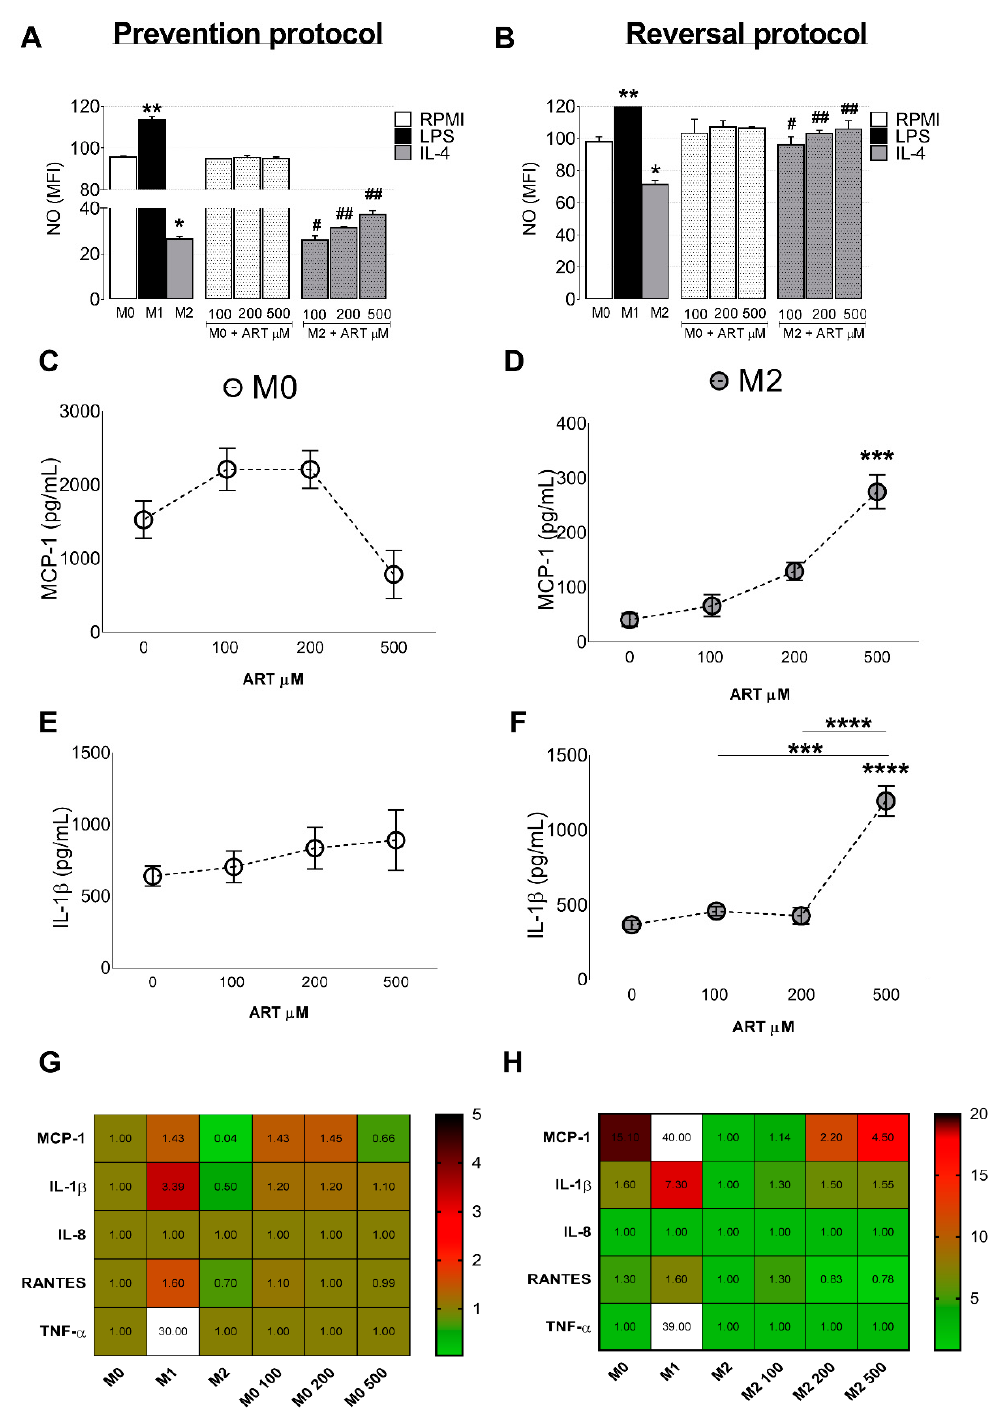
Figure 4. ART treatment induces NO production and MCP-1/IL-1 β release. Monocytes were treated with increased doses of ART (100, 200, and 500 µ M) for 24 h in the prevention protocol in the presence or not of IL-4 ( A ). In the reversal protocol ( B ), cells were treated with IL-4 for 6 h and ART was then added in fresh medium for extra 18 h. NO production was measured by flow cytometry. Cytokine MCP-1 ( C , D ) and IL-1 β ( E , F ) production was measured at the supernatant of cell culture by ELISA. Heat map showing fold change of all cytokines analyzed ( G , H ). Data represent mean ± SEM of at least three independent experiments performed in triplicate. Data were analyzed by ANOVA followed by Tukey post hoc. *, **, *** and, **** significantly different from control M0 cells (white bar). # and ##, significantly different from M2 cells (grey bar). M0: Naive control monocytes maintained in RPMI 10%, M1: positive control for inflammatory monocytes maintained in LPS and, M2: immunosuppressive monocytes maintained in